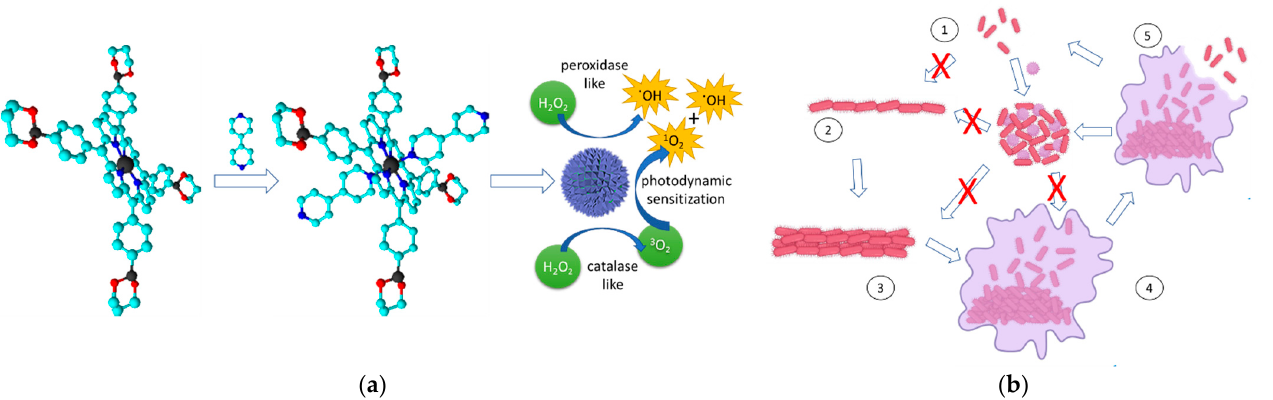
Figure 5. The self-assembly nanozyme formation mechanism and the planktonic bacterial cell aggregation mechanism leading to photodynamic bacterial cell death and biofilm structure destruction. ( a ) Bipyridine mediated self-assembly of the porphyrins to form the porphyrin nanozyme with peroxidase/catalase mimic activities. ( b ) Planktonic cell aggregation mechanism reported by Hu et al. (2022) [163]. (1) planktonic microbial form, (2) surface adhesion, (3) colony formation and maturation, (4) biofilm formation, (5) microbial detachment from biofilm.